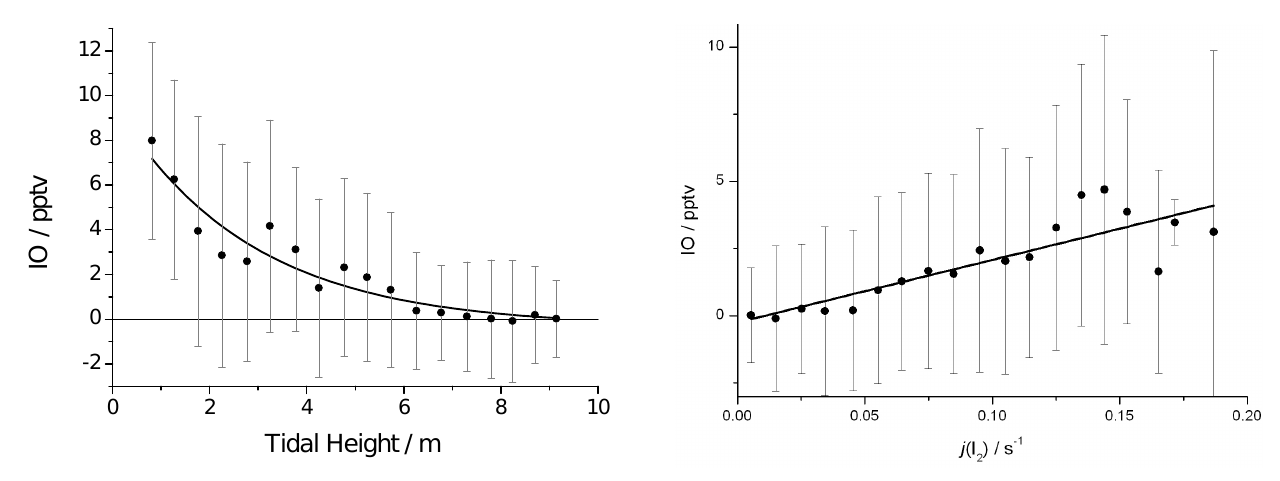
Fig. 4. The relationship between daytime IO and tidal height for the whole campaign (data binned according to 0.5 m width bins of tidal height), using 150 s averaged IO measurements. Error bars represent ± 1 σ standard deviation for all binned data. For each tidal height there is a range of j (I 2 ) depending on the time of day, and other parameters that influence IO, such as NO x and meteorology. The solid line is an exponential decay fitted to the data, as given in the text by Eq. (4).